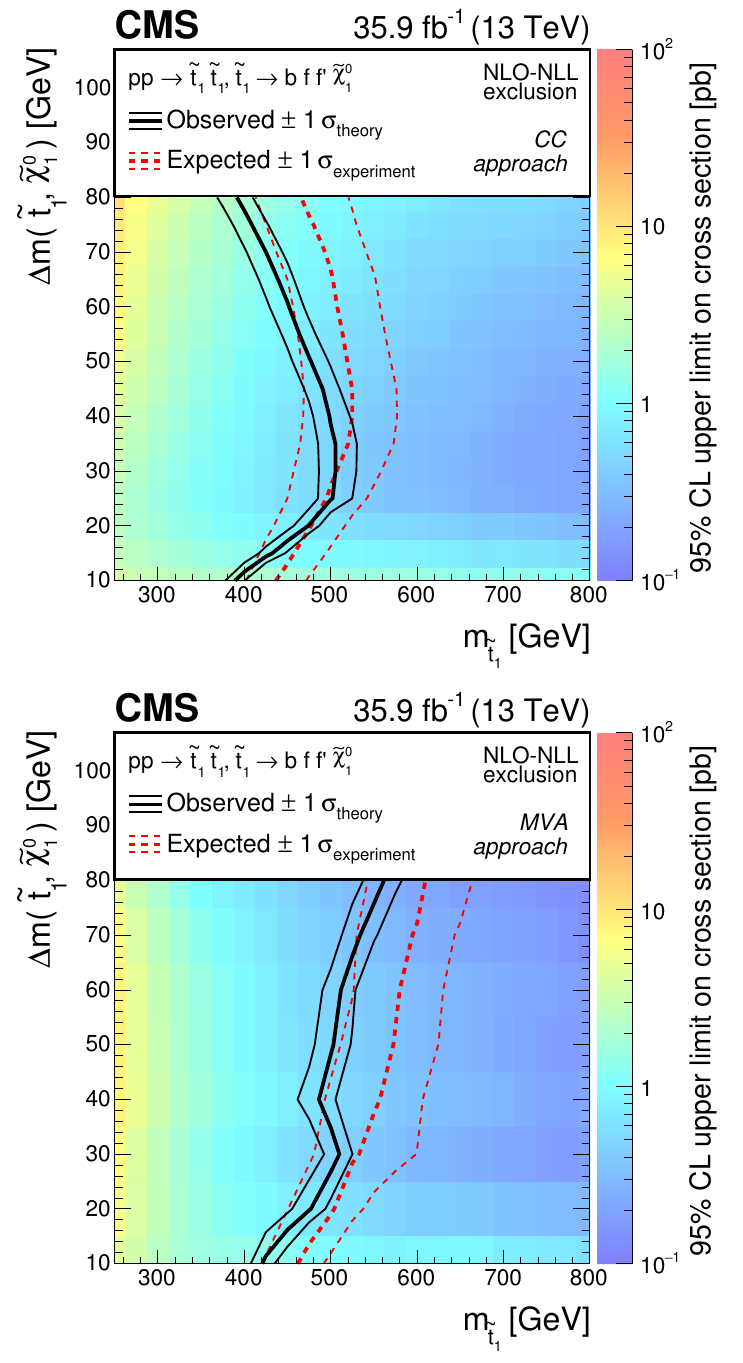
Figure 7 . Exclusion limit at 95% CL for the four-body decay of the top squark as a function of m ( t 1 ) and (cid:1) m for the CC (upper) and MVA (lower) approaches. The colour shading corresponds to the observed limit on the cross section. The solid black (dashed red) lines represent the ob- e served (expected) limits, derived using the expected top squark pair production cross section. The thick lines represent the central values and the thin lines the variations due to the theoretical or experimental uncertainties.